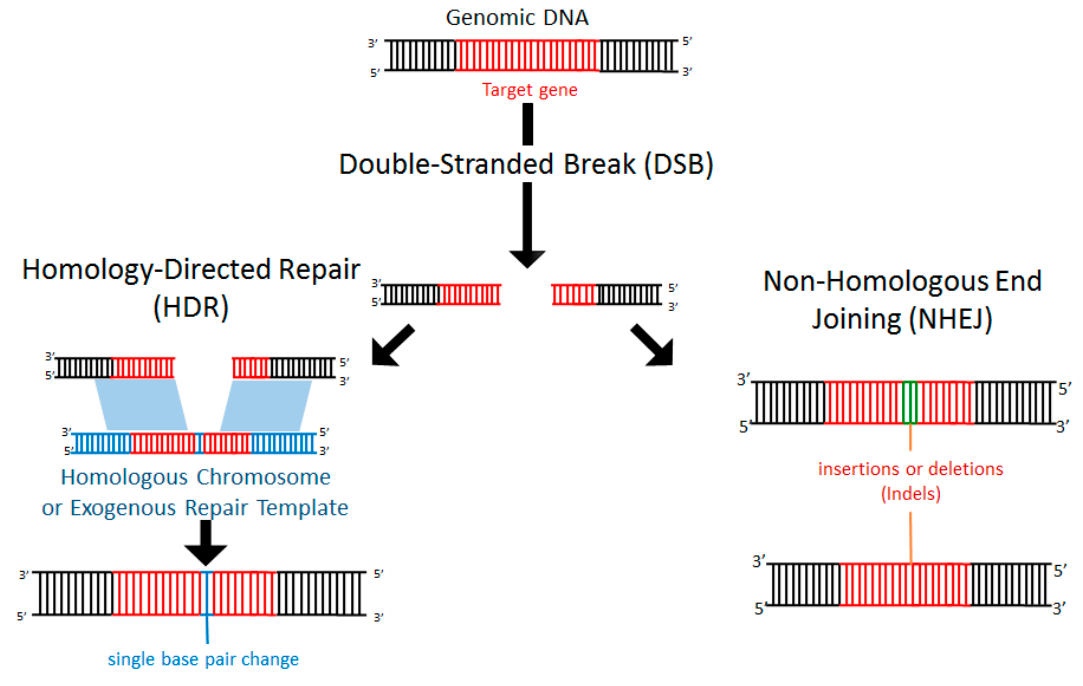
Figure 1. Double-stranded breaks (DSBs) induce endogenous DNA repair mechanisms. DSBs can be repaired by non-homologous end joining (NHEJ) or homology-directed repair (HDR). NHEJ often leads to deleterious insertions or deletions (indels), while HDR leads to high-fidelity DNA repair using the homologous chromosome or exogenously introduced DNA as a template.